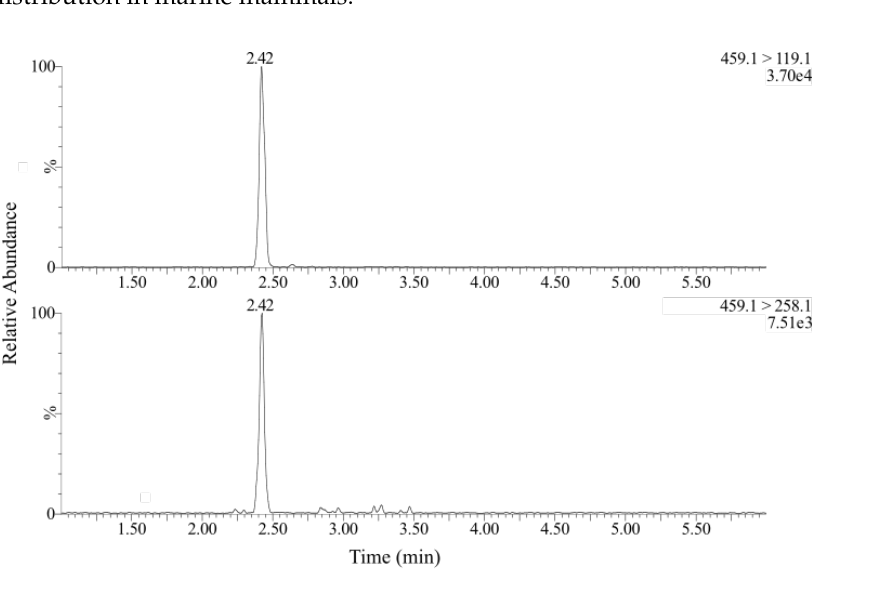
Figure 2. LC–MS/MS chromatograms of liver tissue precipitated bound sample extract spiked with Figure 2. LC – MS/MS chromatograms of liver tissue precipitated bound sample extract spiked 5 ng − 1 mL of BMAA. The selected reaction monitoring (SRM) transitions 459.1 > 119.1 (common to with 5 ng −1 mL of BMAA. The selected reaction monitoring (SRM) transitions 459.1 > 119.1 BMAA and its isomers) and 459.1 > 258.1 (BMAA diagnostic fragment) are (common to BMAA and its isomers) and 459.1 > 258.1 (BMAA diagnostic fragment) are shown